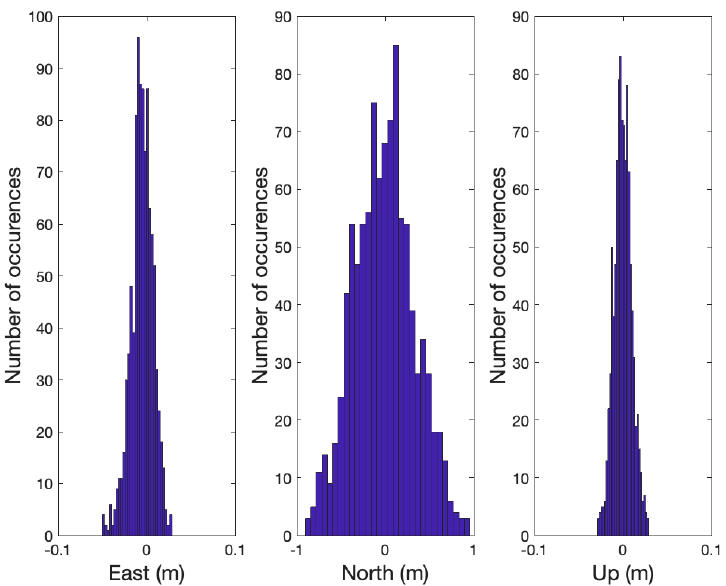
Figure 7. The figure shows the error distribution of the instantaneous a priori relative position, ˆ x MF , aprioi , in ENU coordinates determined by the launchpad and magnetometer in 1000 simulation cases.